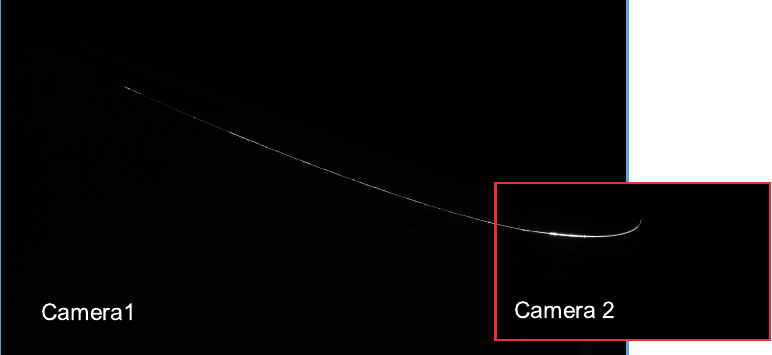
Figure 3. Sample PIV fields of the two cameras with their overlap, shown by means of two original images: The image domains are adjusted separately in different tests, when the PIV plane is moved spanwise or when the angle of attack is